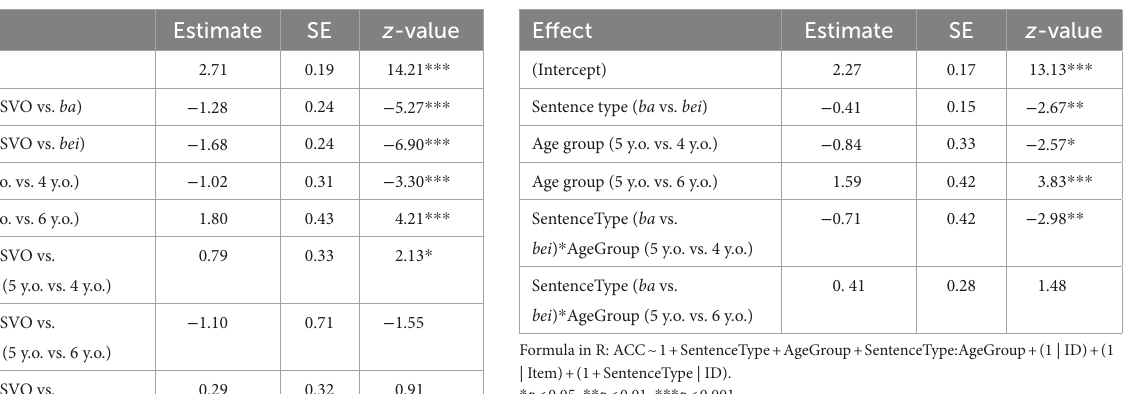
TABLE 8 Fixed effect estimates for multi-level model of the production of ba- and